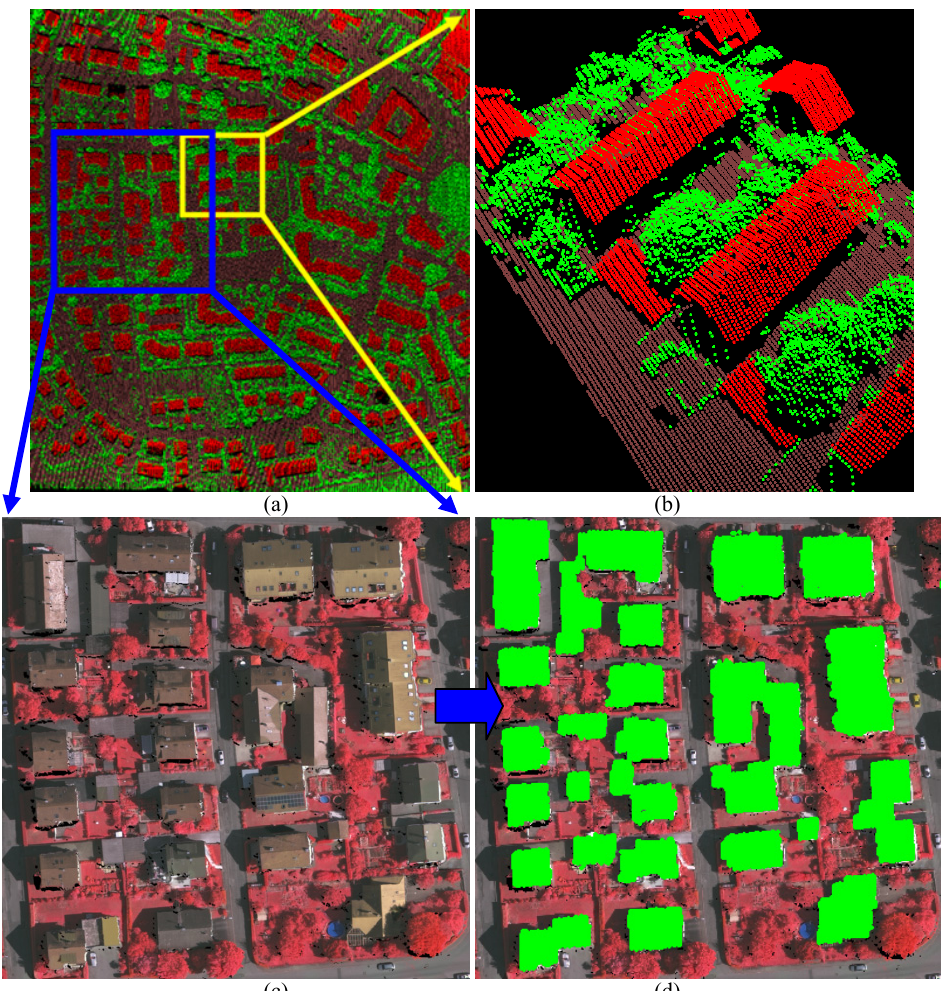
Figure 5: Extraction results of test area 1, (a) point cloud coloured by classification results (red: buildings, green: vegetation, brown: ground); (b) local enlarged view of (a) (3D view); (c) true ortho-photo of test area 1; (d) extracted building points (green) shown on the true